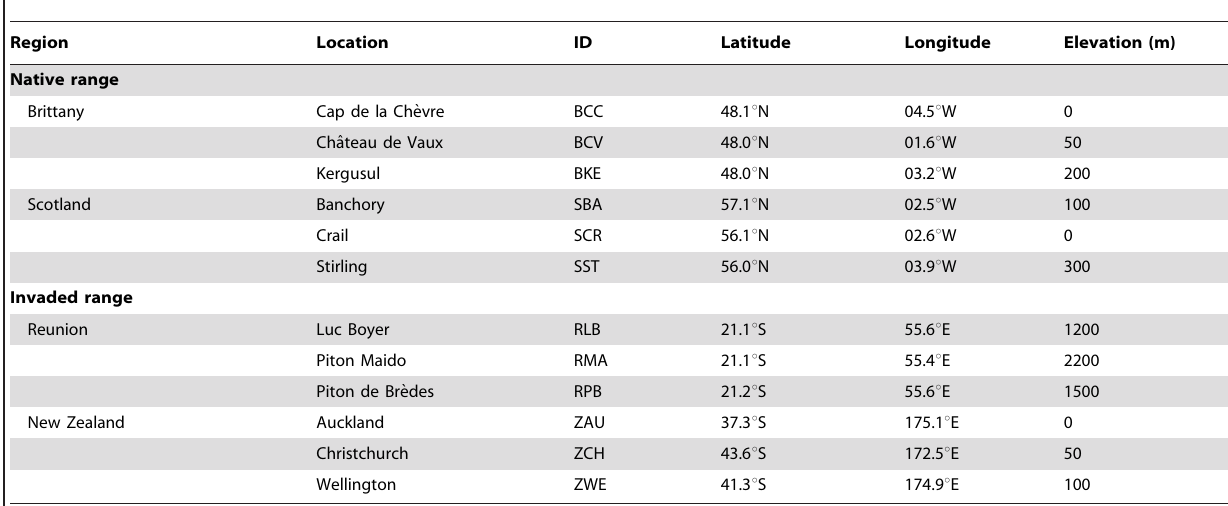
Table 1. Main characteristics of the gorse populations sampled.